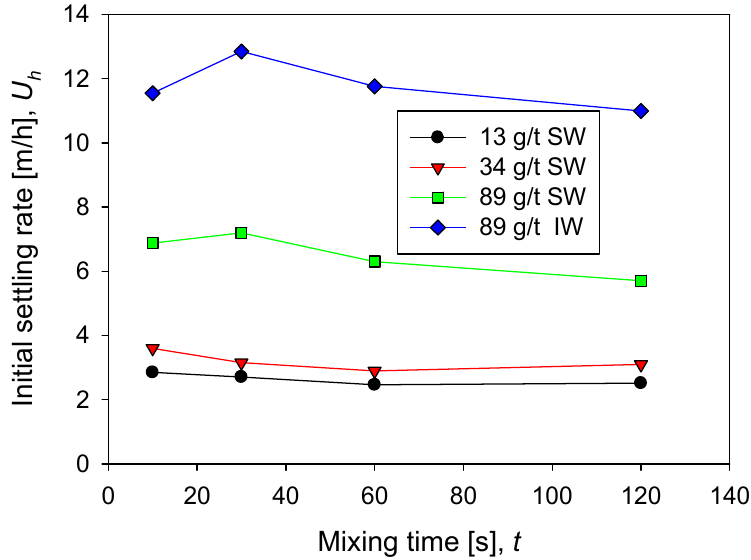
Figure 4. Sedimentation rate of kaolin suspensions with different doses of flocculant in SW and IW at a shear rate of 200